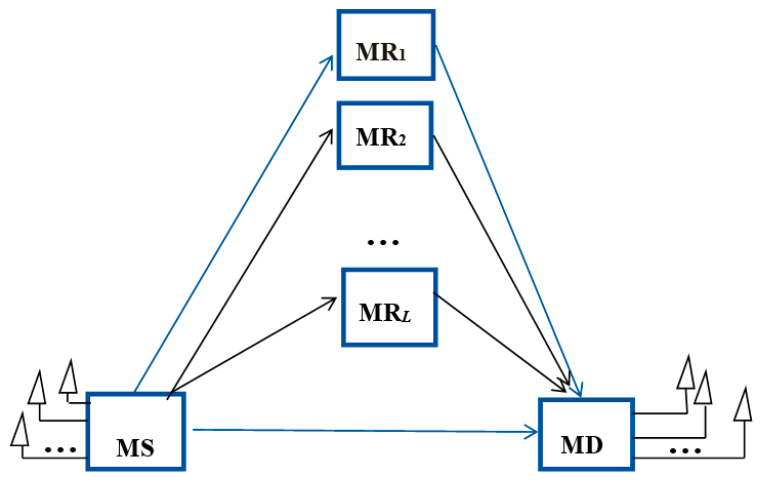
Figure 1. The system model.